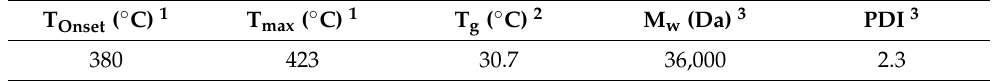
Table 1. Summary of the properties of PHEF.